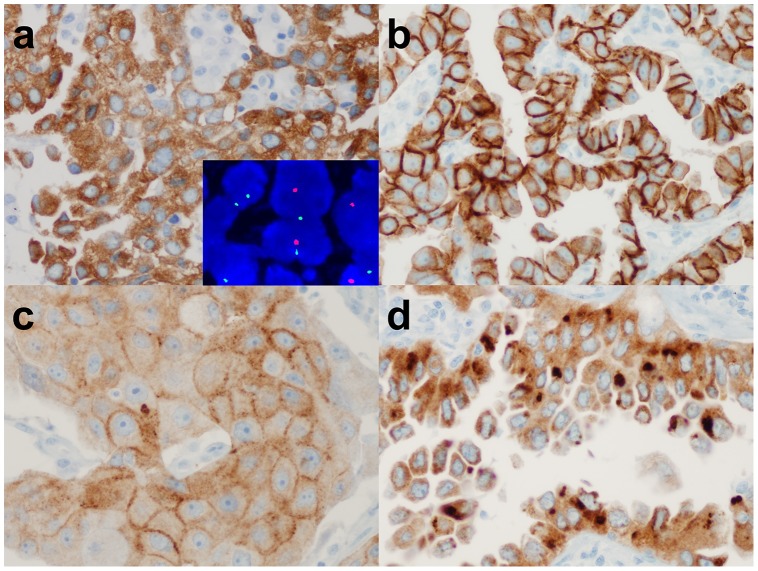
Immunohistochemical findings of ROS1-rearranged tumors.An ROS1-rearrangned tumor showed strong and diffuse cytoplasmic staining (a) (inset: ROS1 FISH with split signals). Other tumors showed cytoplasmic staining with membrane accentuation (b), membranous staining with weaker cytoplasmic intensity (c), or cytoplasmic or paranuclear aggregates (d).